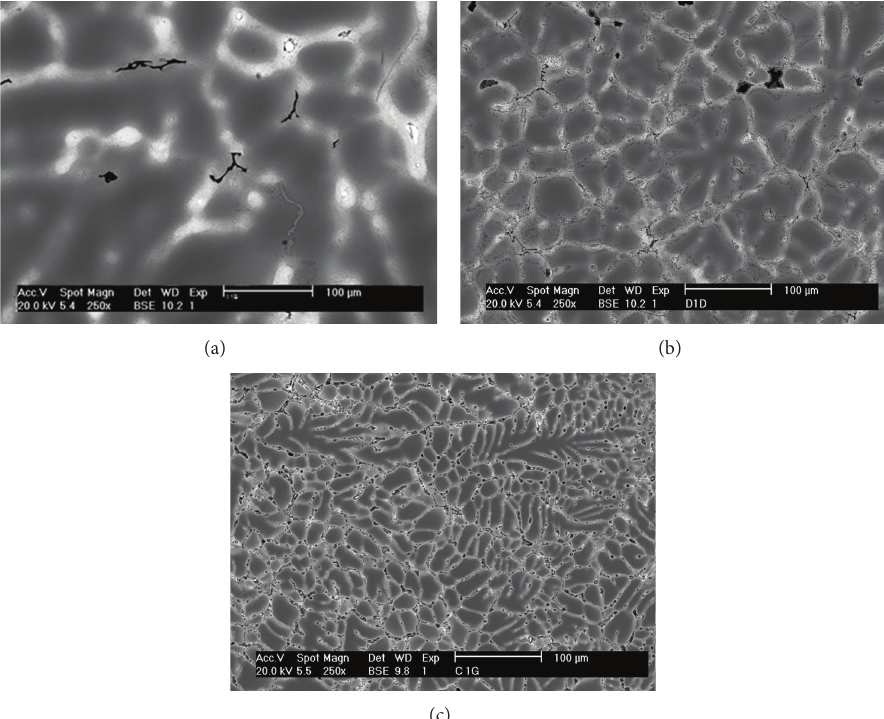
Figure 4: SEM-backscattered electron images illustrating the effect of cooling rate on the solidification microstructure of Al-Zn-Si alloys with 1.5Si wt%: (a) 11.7 ∘ Cs −1 , (b) 31.5 ∘ Cs −1 , and (c) 50.1 ∘ Cs −1